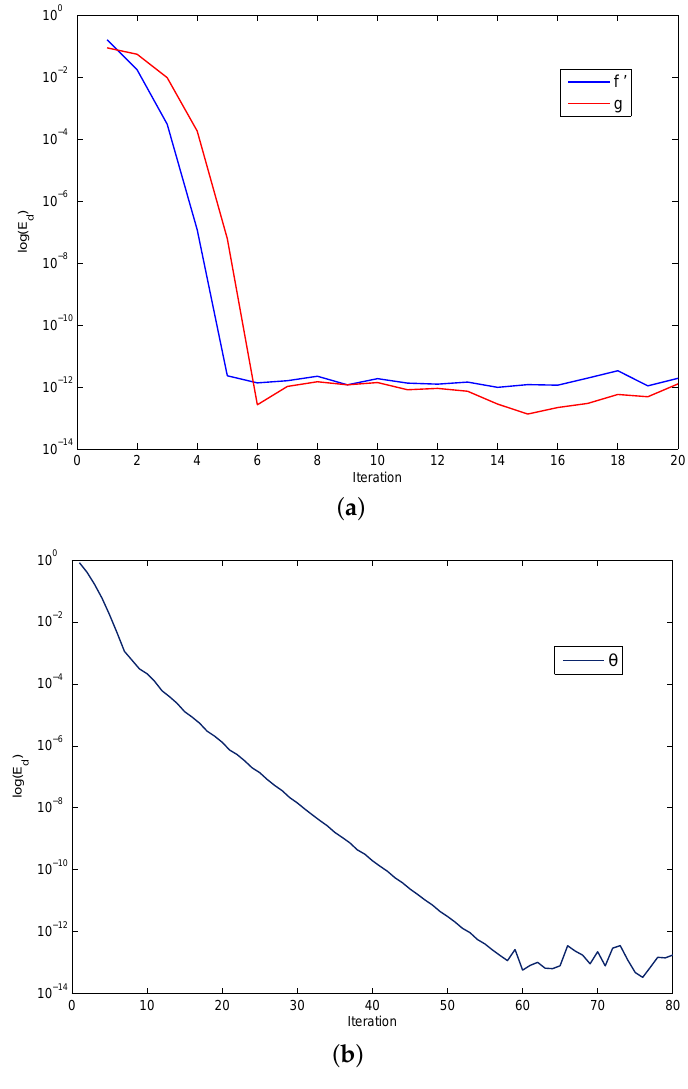
Figure 2. Maximum error in ( a ) f (cid:48) and g , ( b ) θ versus number of